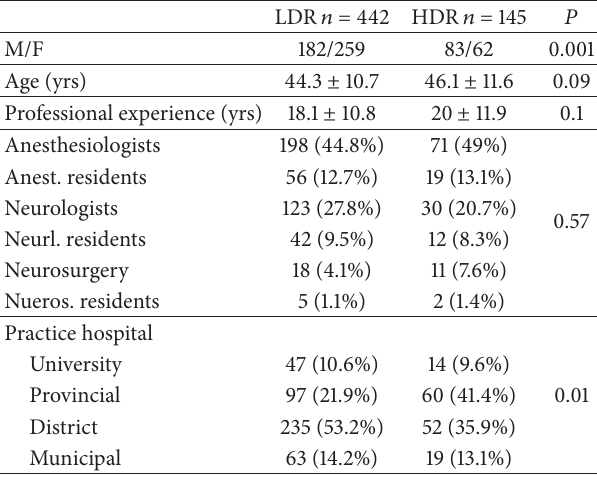
Table 1: Physicians who participated in the survey.